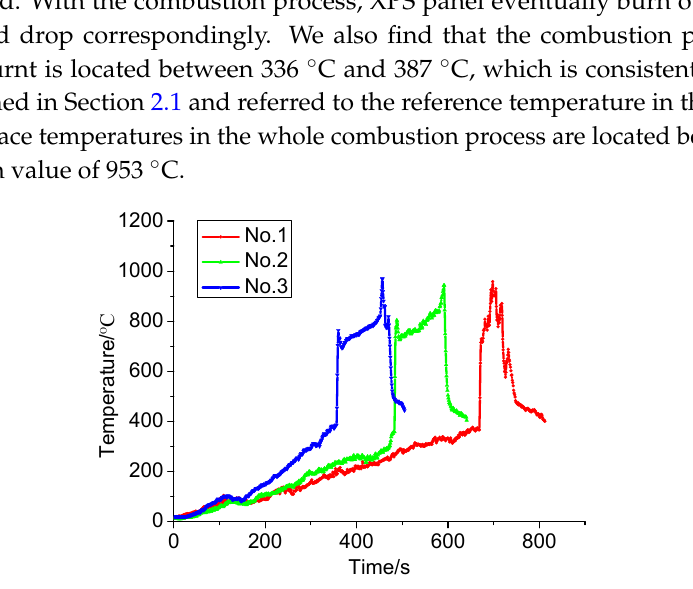
Figure 3. Surface temperature exposed to different heat fluxes.